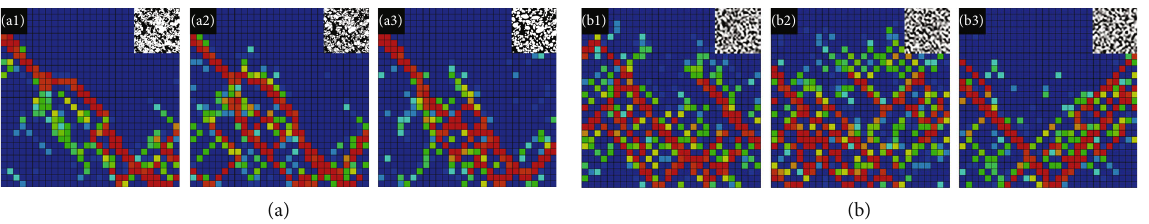
Figure 7: Compressive damage of the (a) simpli fi ed S3-mREAs and (b) random models at point C in Figure 6 under loading in the y -axis